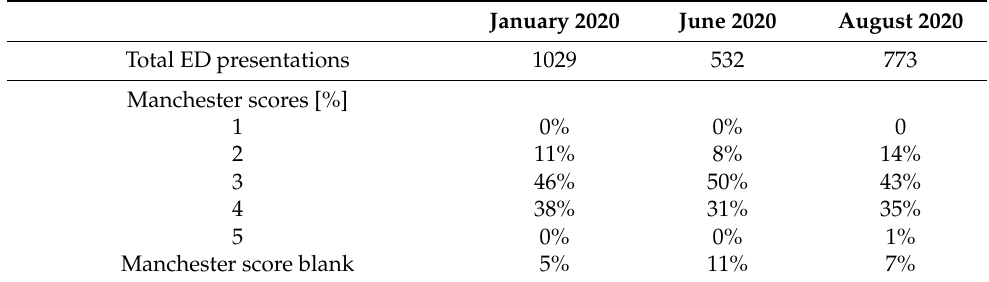
Table 4. Activity, patient acuity, patient flow data for the emergency department January, June,